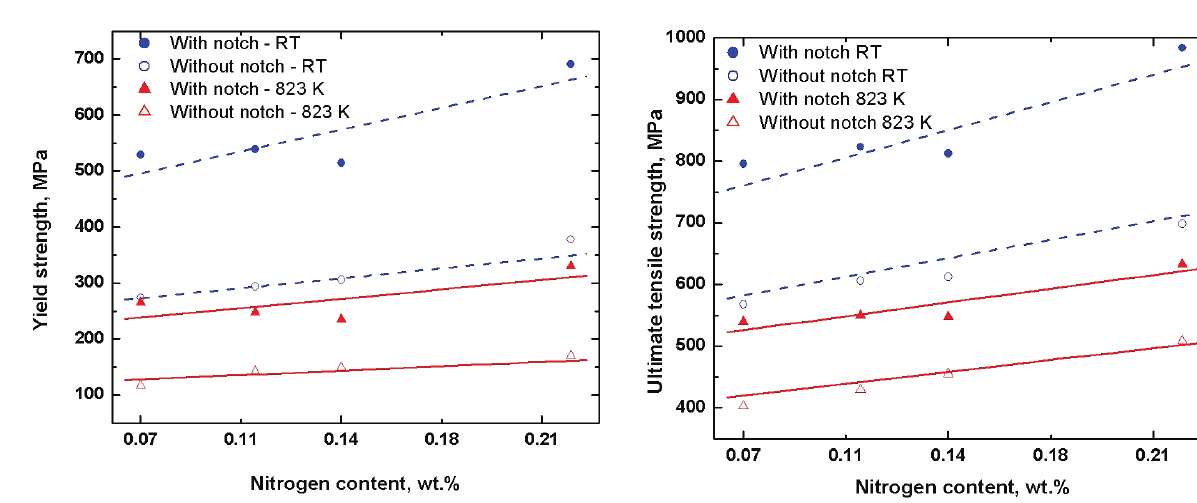
Table 2. Tensile properties of the four heats of 316LN SS from smooth and notch specimens.